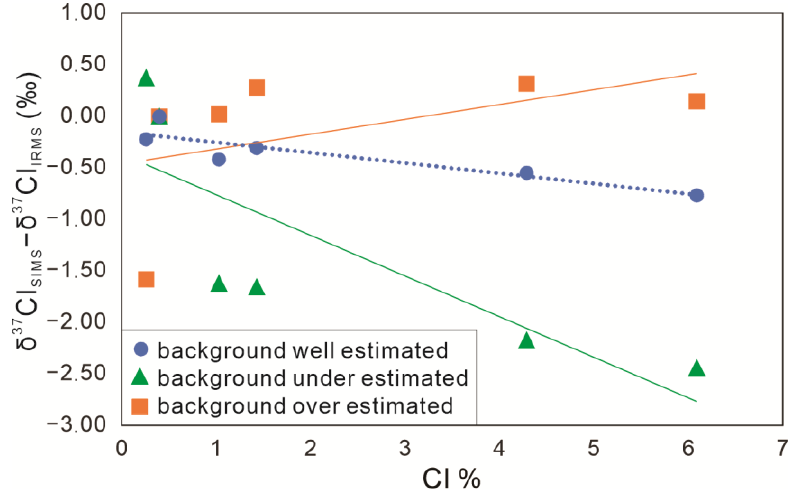
Figure 5. An inappropriate background subtraction could cause the ΔIMF trend to change from negative to positive. A 5000 cps was subtracted (or added) to the 37 Cl − channel (H1) as an example.